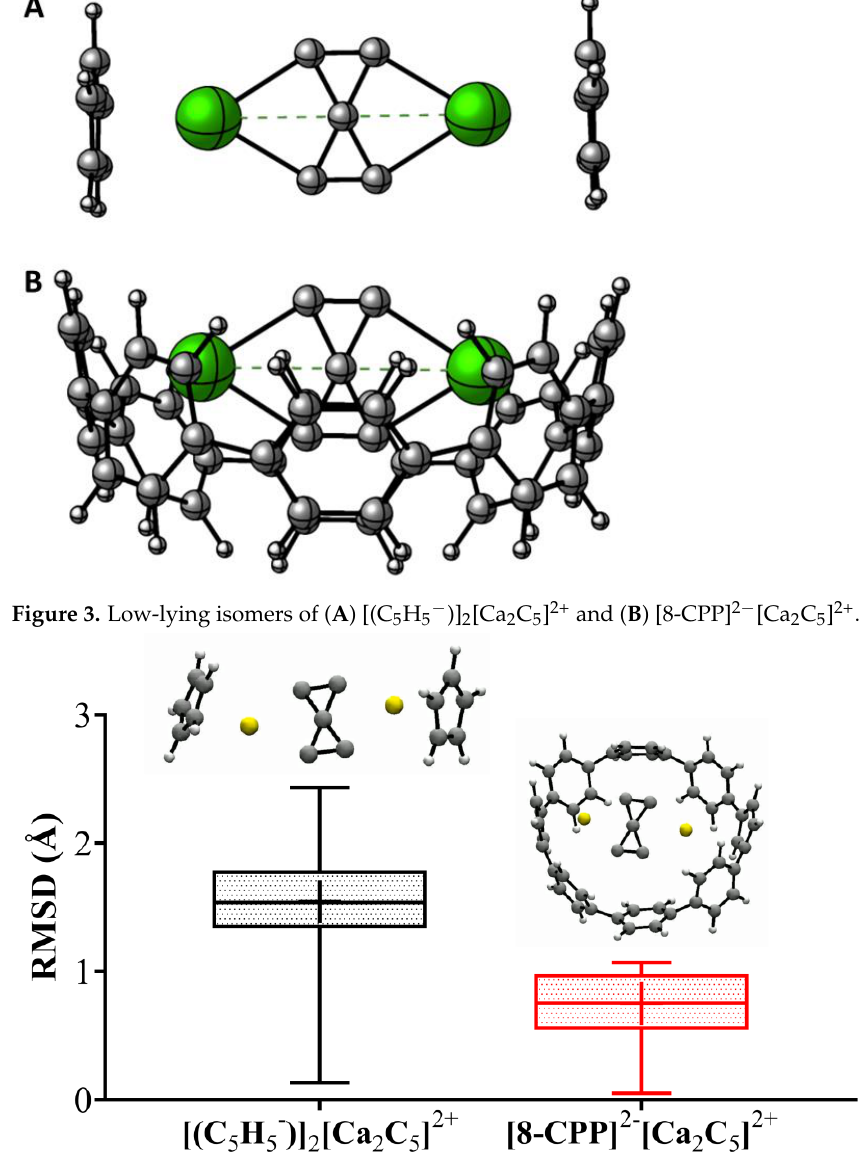
Figure 4. Boxplot of RMSD fluctuation of ab initio BOMD simulations for [(C 5 H 5 − )] 2 [Ca 2 C 5 ] 2+ and [8-CPP] 2 − [Ca 2 C 5 ] 2+ systems.